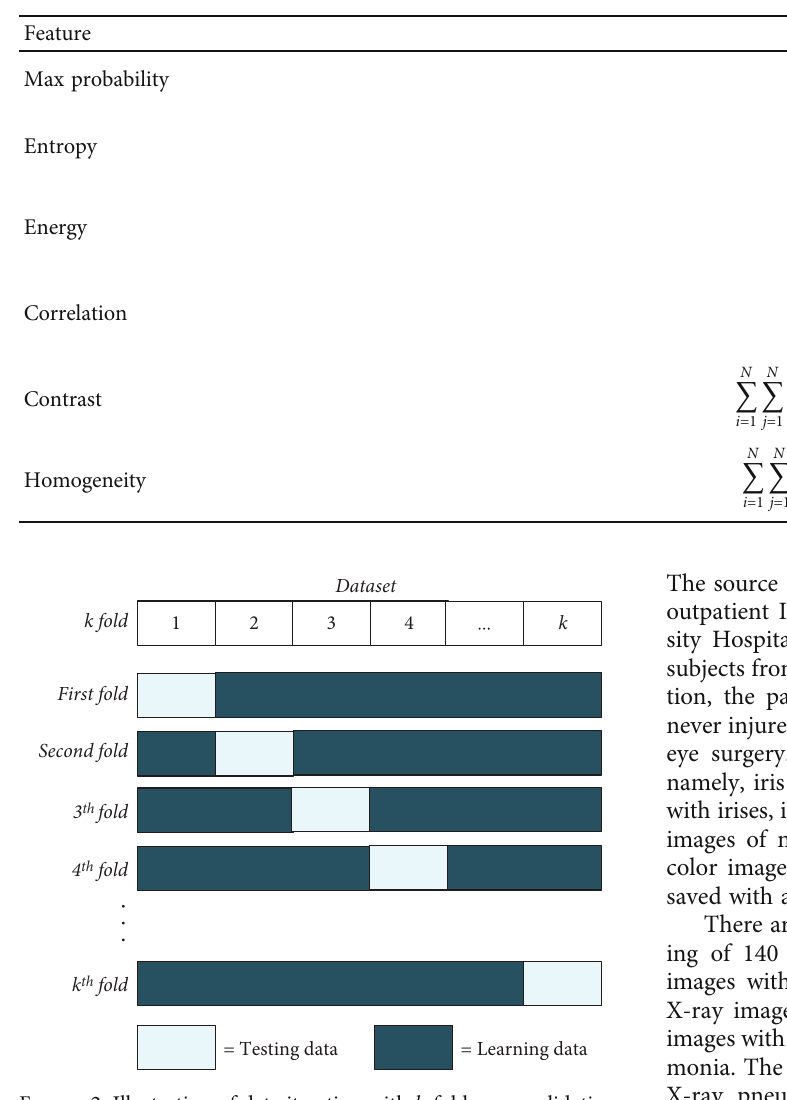
Table 2: Texture features calculated from 3D-GLCM invariant.